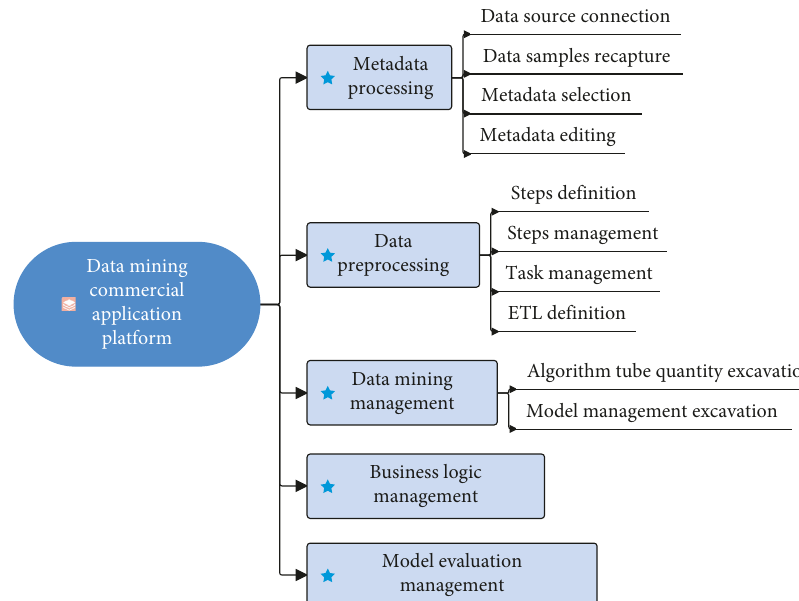
Figure 9: Platform module structure